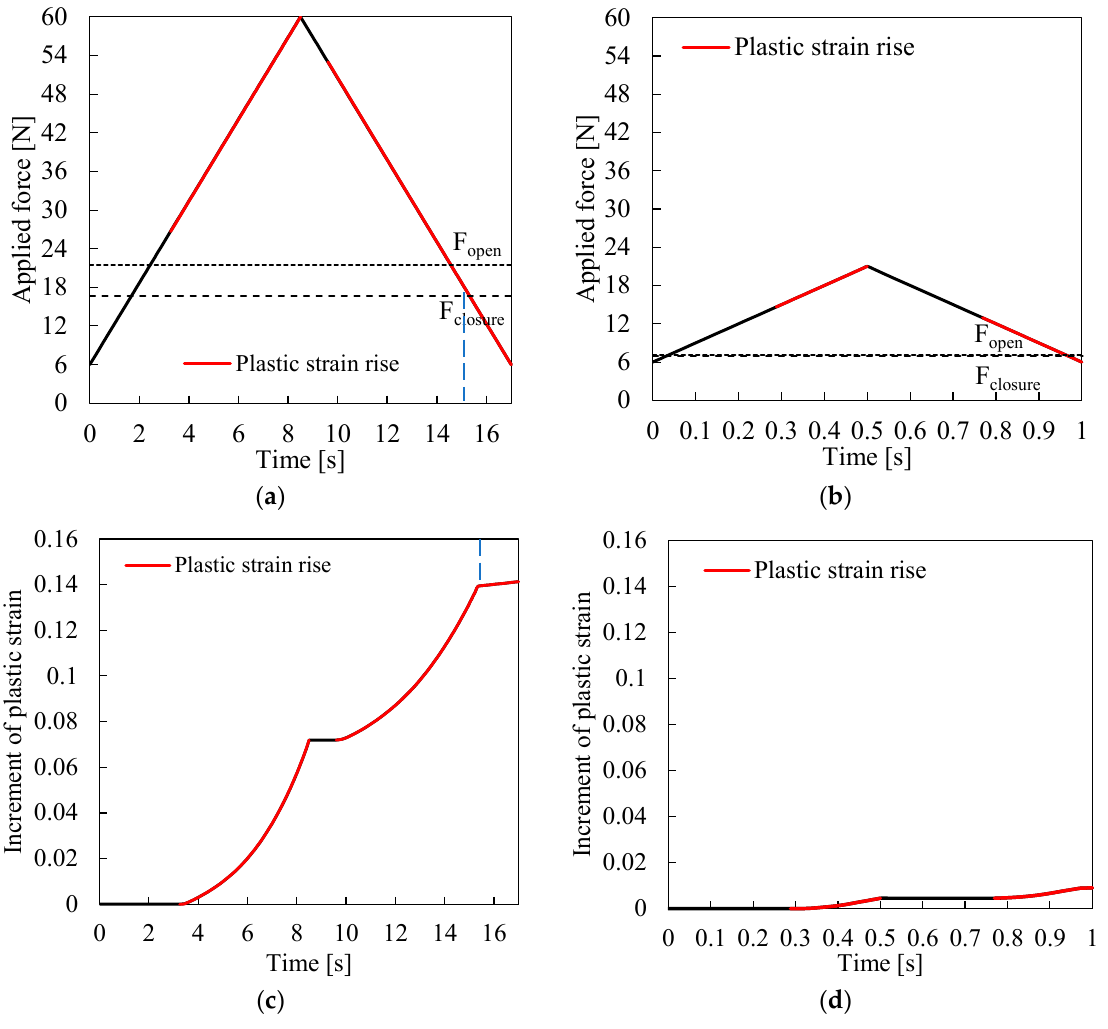
Figure 6. Evolution of plastic deformation during loading to a = 15.30 mm: ( a ) low-frequency pattern; ( b ) plastic strain rise of low-frequency pattern; ( c ) low-frequency pattern; ( d ) plastic strain rise of high-frequency pattern.